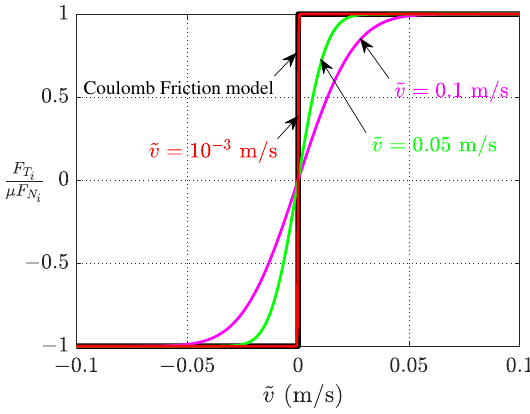
Figure 4. Approximation of actual friction force by a Regularization friction